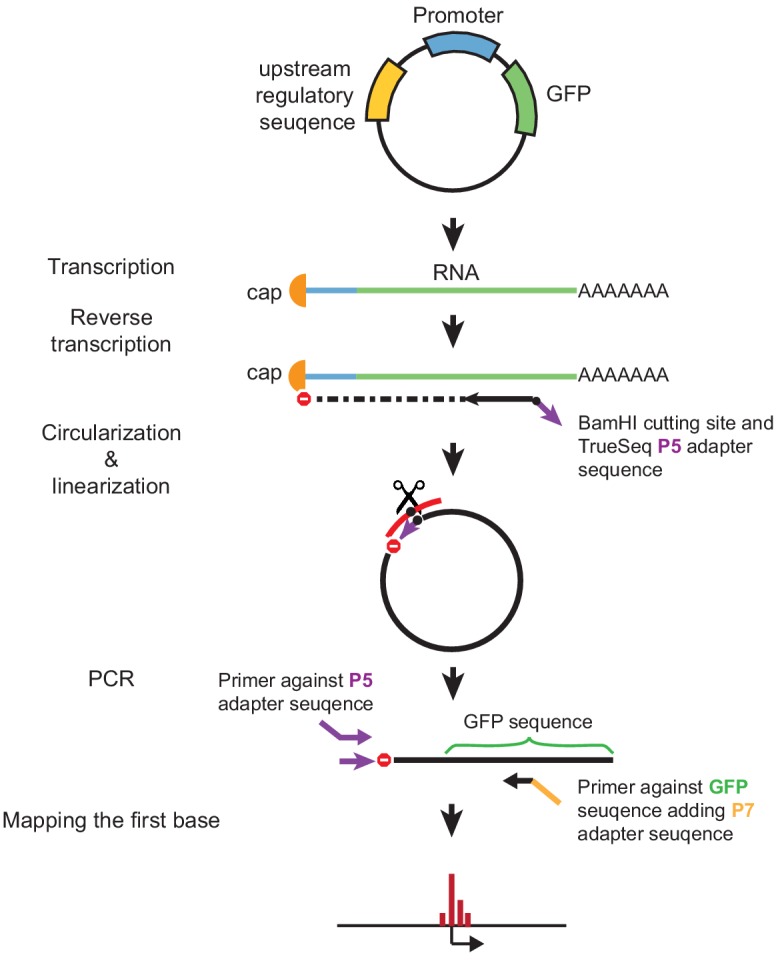
Workflow for gene-specific 5’ RNA sequencing, a method similar to RNA amplification of cDNA ends (RACE).RNA transcribed form the reporter was reverse transcribed using a primer that has 3’ sequences complementary to the GFP sequence. The 5’ of this primer contains a BamHI restriction cutting site and a partial reverse TruSeq P5 adapter sequence (purple). When the reverse transcriptase reaction is complete (usually stopping at the cap), each generated cDNA contains the TruSeq P5 adapter sequence. After purification, the single-stranded cDNA is circularized to bring the TruSeq P5 adapter sequence to the cDNA 3’ end, where the reverse transcriptase stops. The product is then linearized again by digesting with BamHI (scissors) after making the restriction enzyme cut site double-stranded by annealing it to a complementary oligos (red). The resulting DNA is then amplified in a PCR with a primer that contains the full-length P5 sequence (matching the partial P5 sequence), as well as a primer that primes on the GFP sequence (black) and has the full-length P7 adapter sequence at the 5’ end (yellow). The library is then sequenced with a P5 primer and after alignment to the plasmid, the first base is recorded. These bases correspond to the site where the reverse transcriptase stopped transcribing, which should occur at the 5’ end of the RNA, where the cap is found.